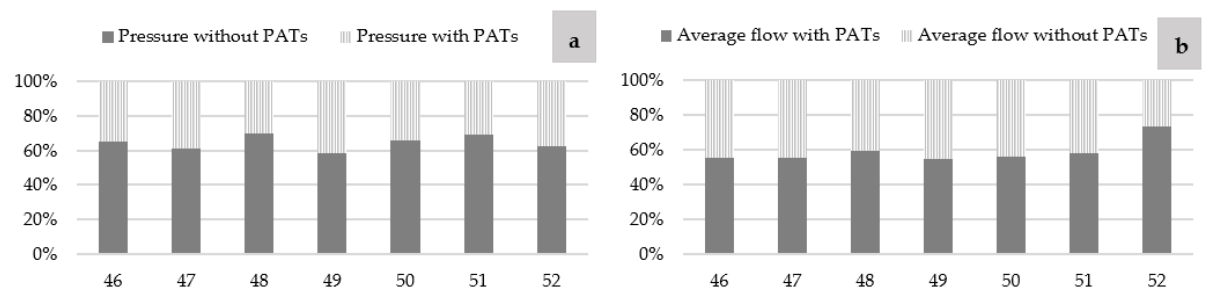
Figure 7. Influence of the installation of PATs. Comparison of network pressure by the installation of PATs ( a ); Comparison of flow injected into the network by the installation of PATs ( b ).